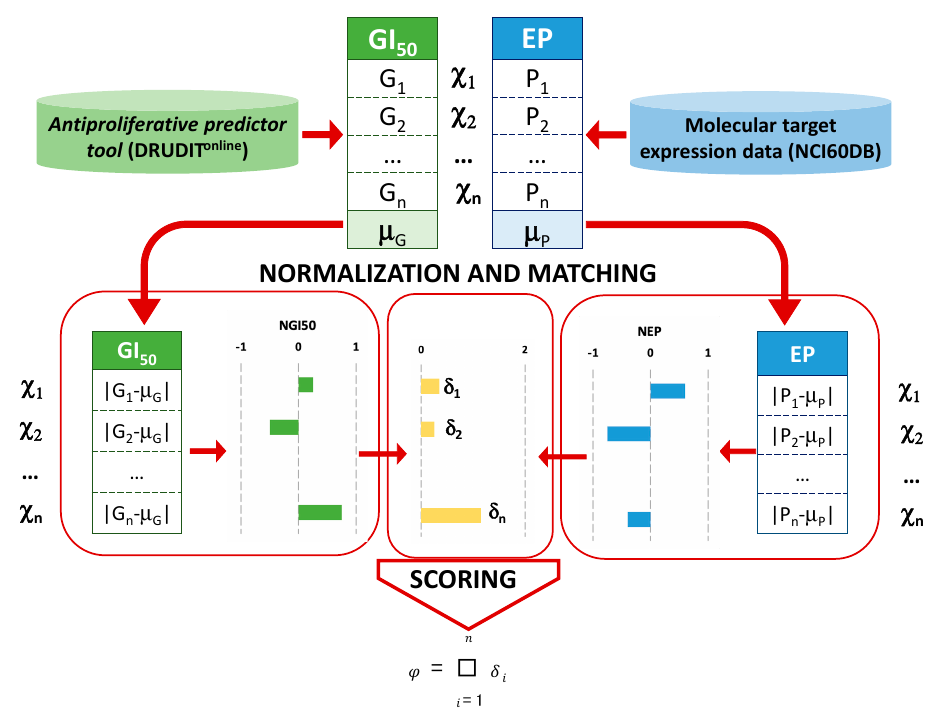
Figure 6. Workflow for the assessment of the correlation between the antiproliferative activity values (expressed as GI 50 s) and expression patterns (Eps) on NCI60 cancer cell lines χ i .